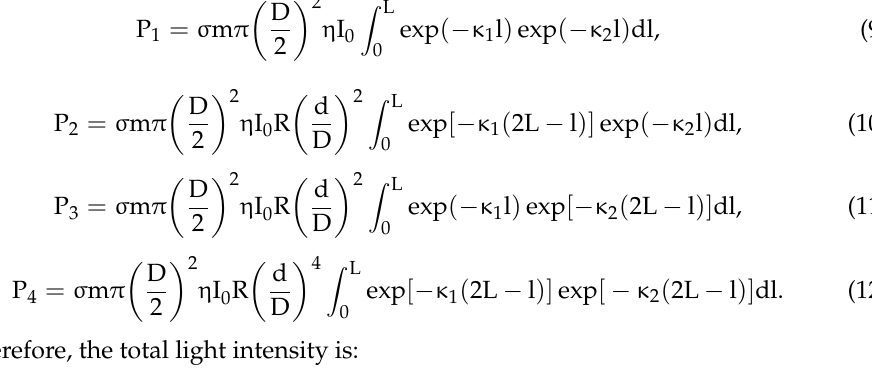
Figure 5. Diagram of light propagation in the Sagnac loop. © (2018) IEEE. Reprinted, with permission,